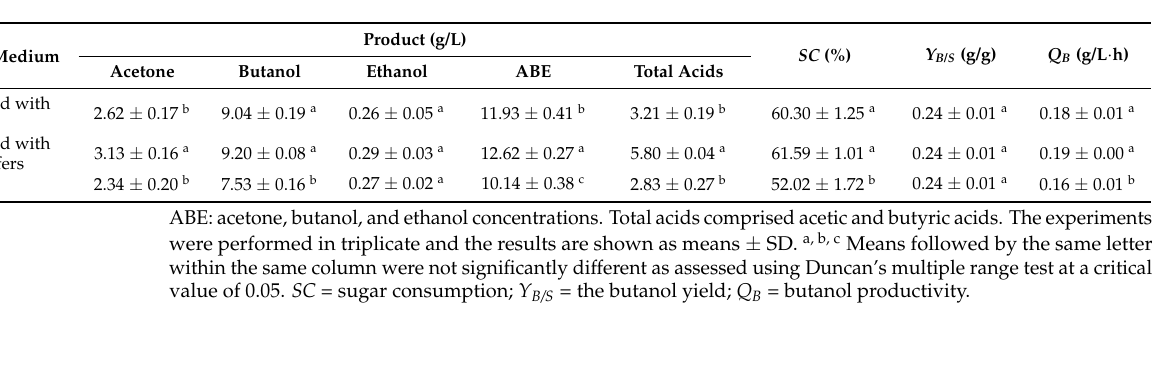
Table 7. Butanol fermentation efficiencies from SSJ medium by immobilized C. beijerinckii TISTR 1461